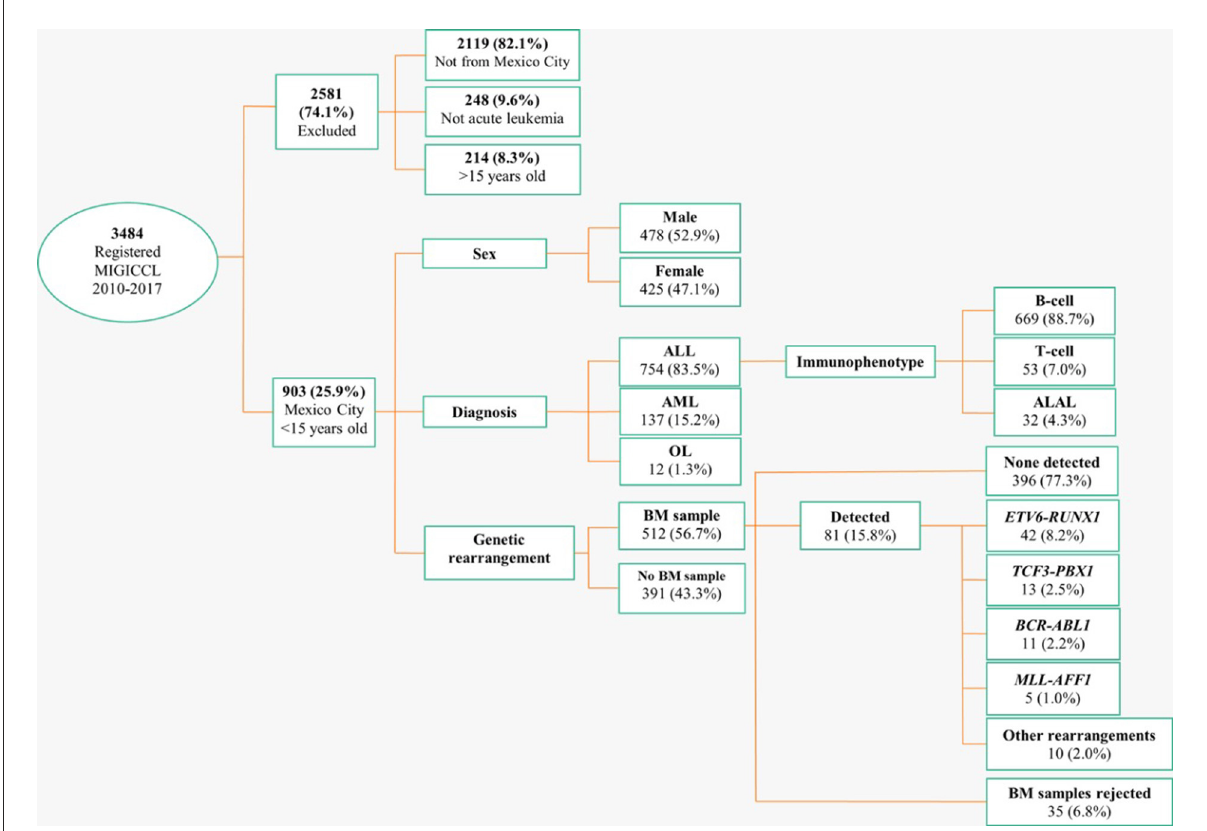
FIGURE1 Flow chart of the selection process. The incidence rate of AL among children of MC during the period 2010–2017 based on the MIGICCL registry. MIGICCL, Mexican Interinstitutional Group for Identification of the Causes of Childhood Leukemia; ALL, acute lymphoblastic leukemia; AML, acute myeloblastic leukemia; OL, other leukemias; BM, bone marrow; ALAL, AL of ambiguous